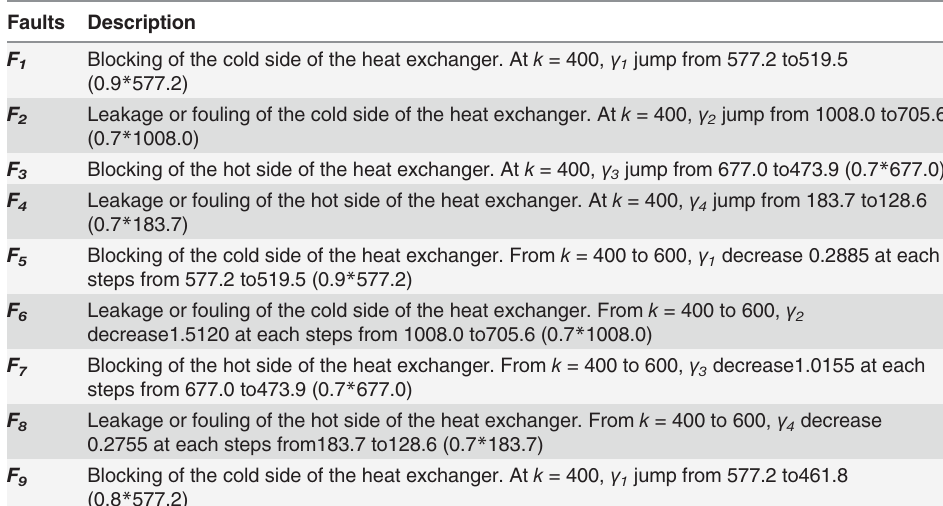
” to “ F ” are gradual faults. “ F ” is more serious than 5 8 9